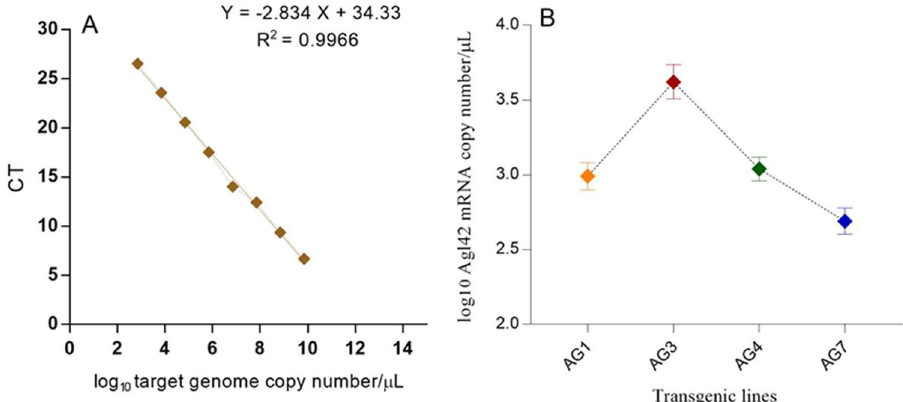
Figure 1. mRNA expression of Agl42 gene in transgenic cotton lines (T1 Generation) ( A ) Standard curve showing log10 values of Agl42 plasmid copy number ( B ) The mRNA copy number of Agl42 gene in different transgenic lines determined by relative absolute quantification.